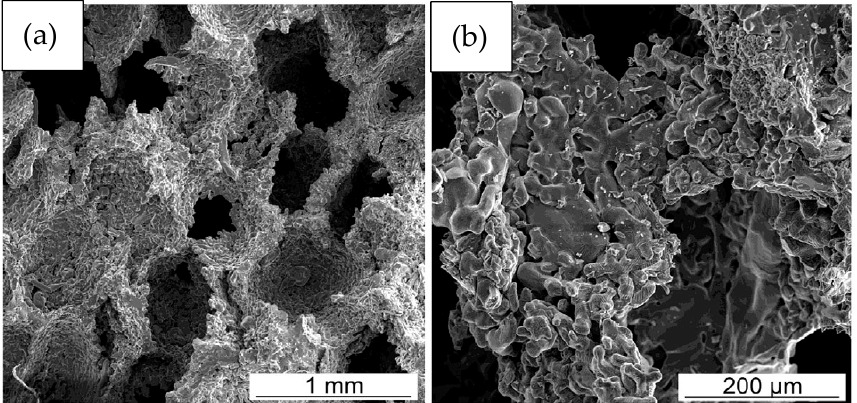
Figure 9. SEM images of porous titanium produced via powder metallurgy: ( a ) microporosity and ( b ) substructure of the wall showing microporosity. Adapted with permission from Ref. [97]. Copyright 2022, John Wiley and Sons.